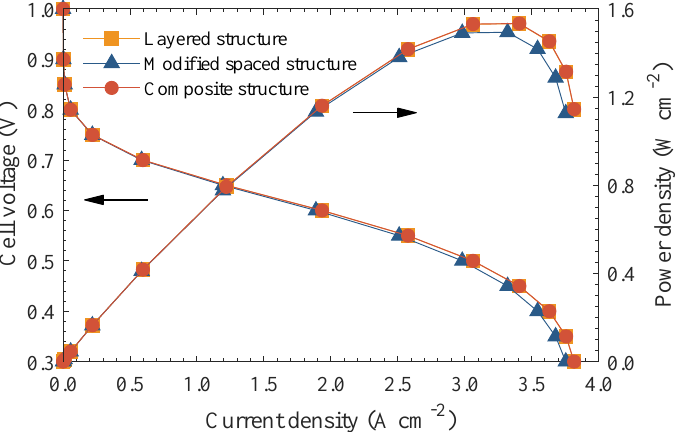
Figure 9. Comparison of the cell performance of PEMFCs cooled by HPBPs with different inter- nal